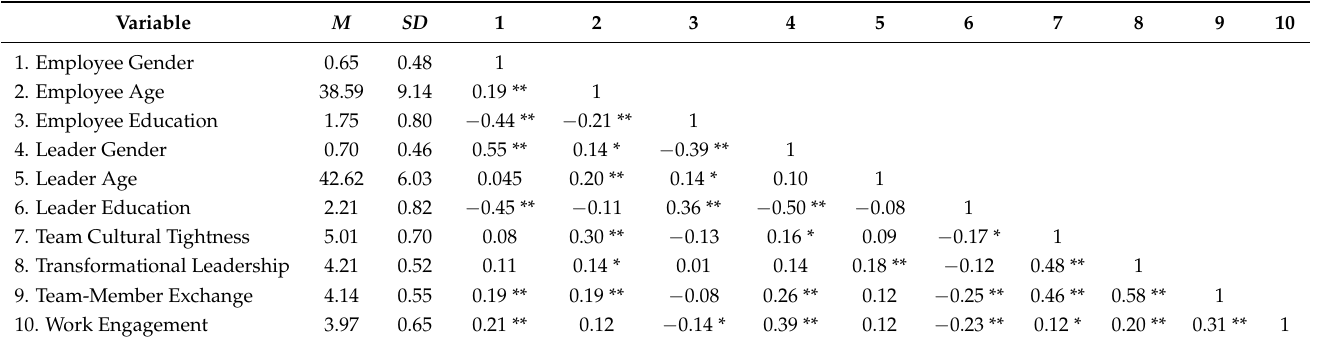
Table 1. Correlation Analysis Results Between